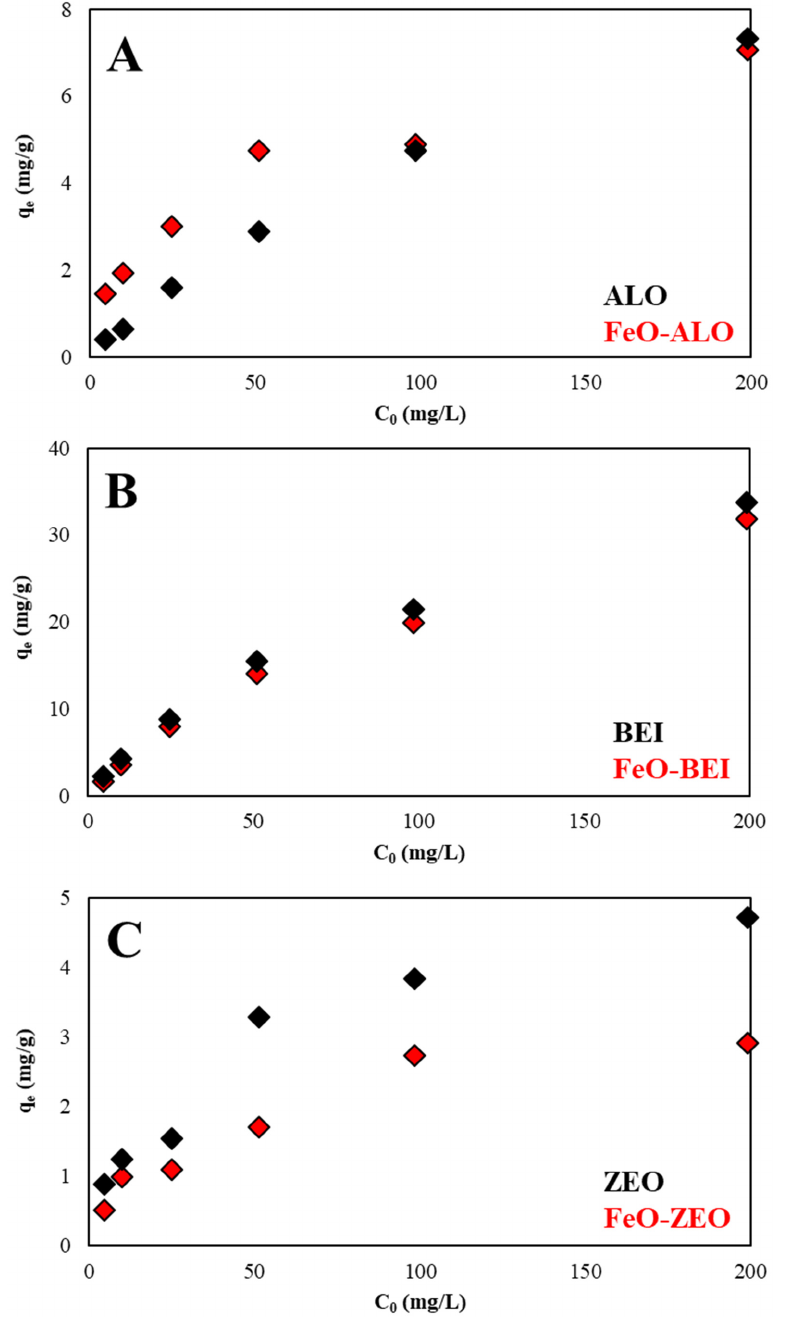
Figure 7. E ff ect of the initial Ba 2 + concentration (operational conditions: 298 K, pH 6.0, Figure 7. Effect of the initial Ba 2+ concentration (operational conditions: 298 K, pH 6.0, adsorbate/adsorbent ratio: 500:1, 5–200 mg/L Ba) on the adsorption of aqueous Ba 2+ by natural and adsorbate / adsorbent ratio: 500:1, 5–200 mg / L Ba) on the adsorption of aqueous Ba 2 + by natural FeO-modified ALO ( A ), BEI ( B ) and ZEO ( C ). and FeO-modified ALO ( A ), BEI ( B ) and ZEO ( C